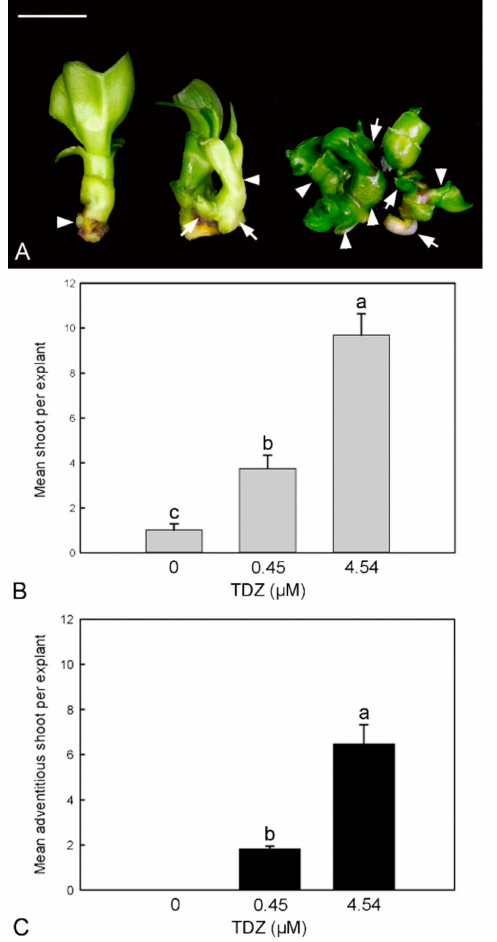
Figure 3. The effect of TDZ treatments on shoot multiplication in vitro. ( A ) Micropropagated shoots after 30 days of inoculation by TDZ treatment. In the control ( left ), the micropropagated shoot showed strong apical dominance without shoot multiplication. The axillary shoot bud (arrowhead) did not become enlarged. In 0.45 µ M TDZ treatment ( central ), one axillary shoot bud (arrowhead) developed from the basal of the original micropropagated shoot, then it further produced two adventitious shoot buds (arrows). In 4.54 µ M TDZ treatment ( right ), the formation of a number of axillary shoot buds (arrowheads) and adventitious shoot buds (arrows) from the original micropropagated shoot (right). Bar = 1 cm. ( B ) Effect of TDZ treatments on the mean number of shoot bud per explant after 30 days of culture. ( C ) Effect of TDZ treatments on the mean number of adventitious shoot bud per explant after 30 days of culture. Data were analyzed using one-way ANOVA with Tukey’s honest significant difference (HSD) test, and significant differences are indicated by different letters at p < 0.05